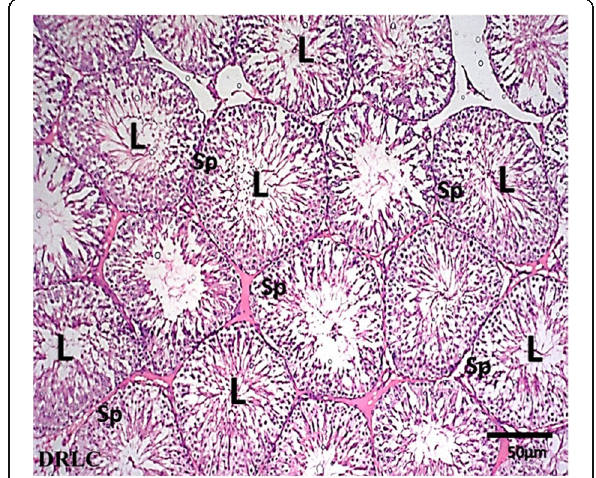
Fig. 16 Representative micrograph from the DRLC group. Observe the seminiferous tubules with well-rounded outline. Present in the germplasm is an array of spermatogenic cells (Sp). The lumina (L) also contains copious quantity of spermatids. Stain H&E; Scalebar: 50 μ